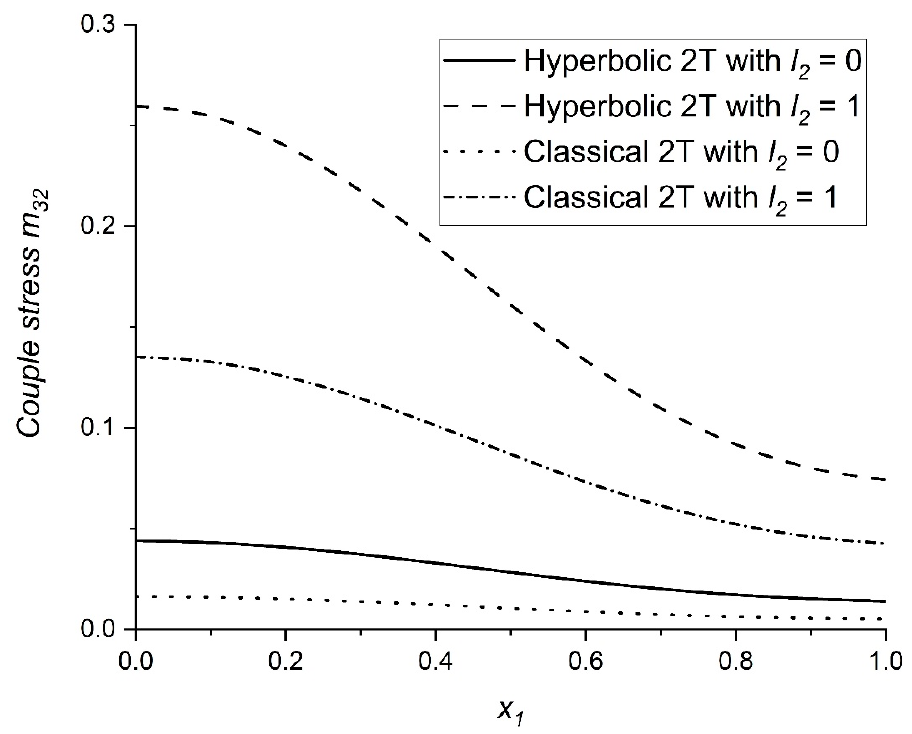
Figure 9. Variations in dimensionless couple stress m 32